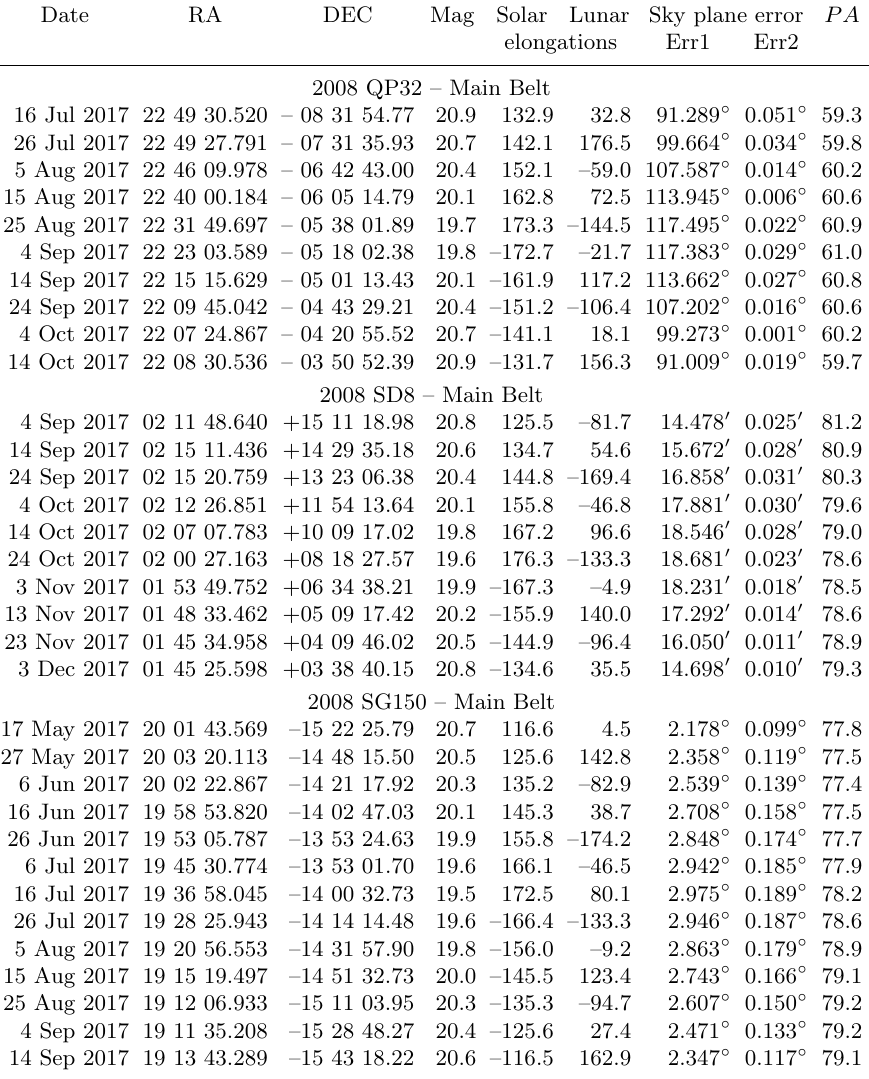
Table 4. Ephemerides for 2017 (geocentric observer) of the asteroids of low accuracy discovered at the Mol˙etai Observatory